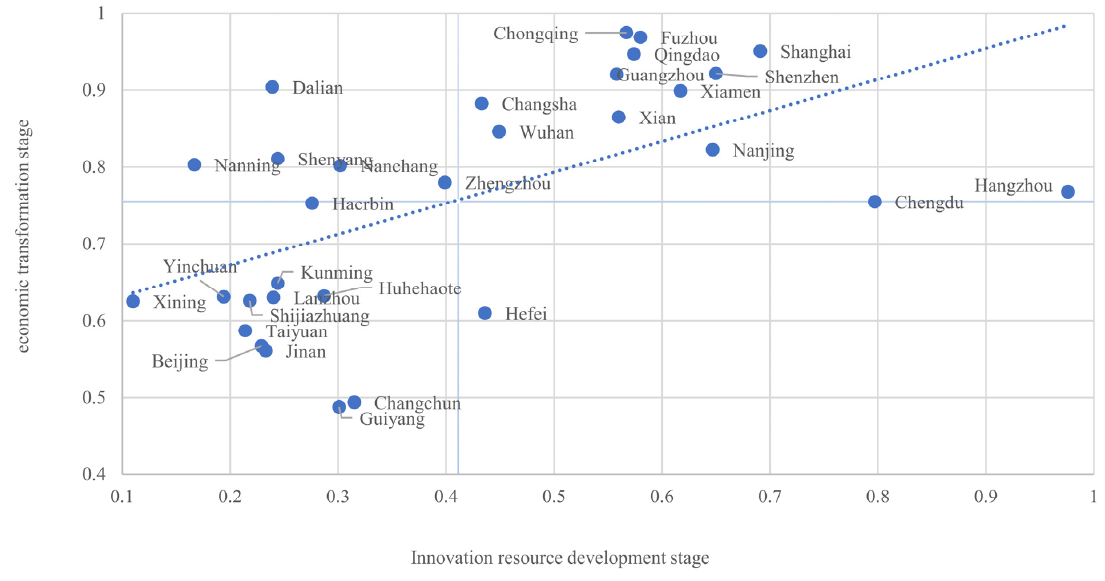
Figure 3. Scatterplot of innovative resource allocation efficiency in metropolitan areas.